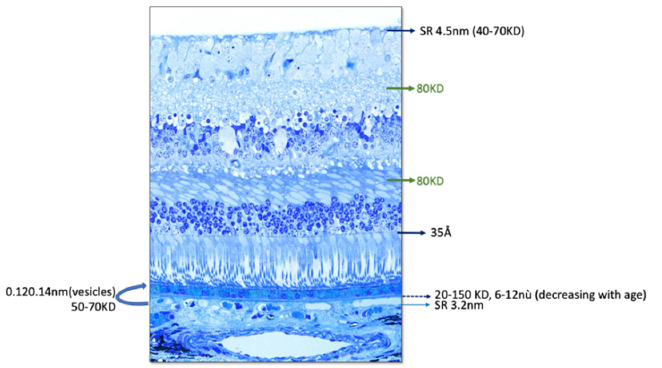
Figure 4. Semi-thin section of human retina with indication of known size and molecular weight limits of the different layers and tissue structures (SR = Stokes radius).